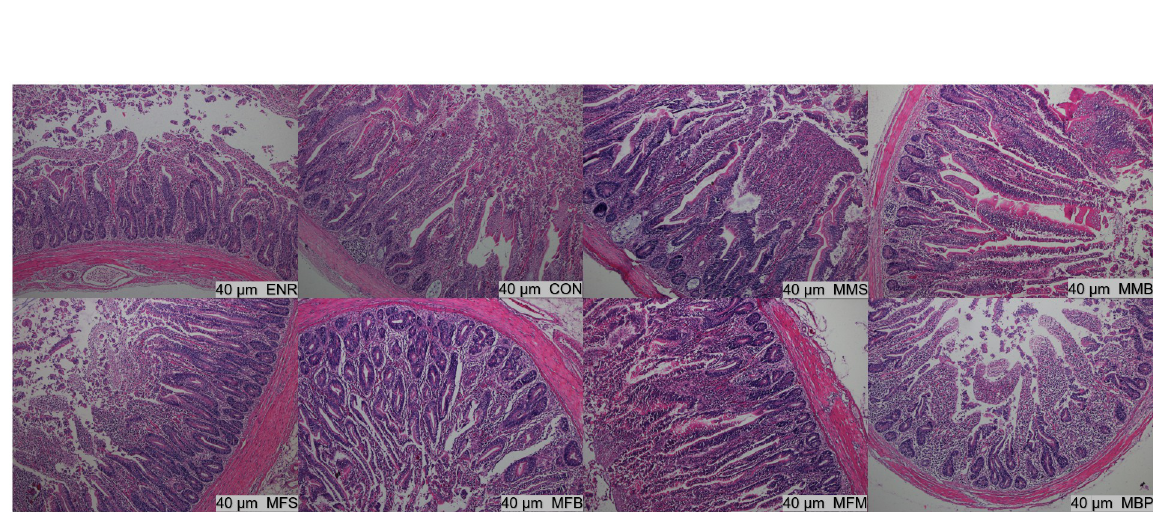
Fig 1. Histological structure of Hematoxylin and Eosin (H&E) staining jejunum at 21 day of age. CON, control diet; ENR; CON + 100 mg/kg ENR, MMS; CON + 2000 mg/kg MOS + 300 mg/kg MAN + 1500 mg/kg SB, MMB; CON + 2000 mg/kg MOS + 300 mg/kg MAN + 500